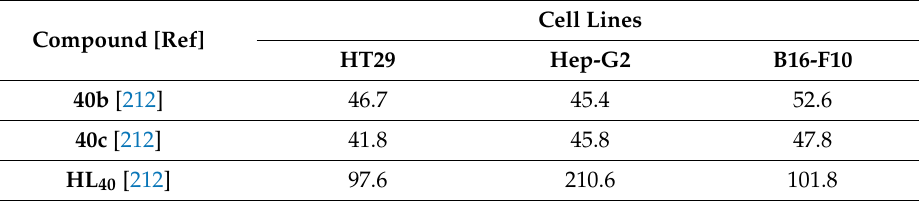
Figure 21. Structure of the zinc complexes 40a – c . Table 11. IC 50 values (µg/mL) for zinc complexes 40b and 40c and ligand HL 40 against different cancer cell lines, after an incubation time of 72 h.